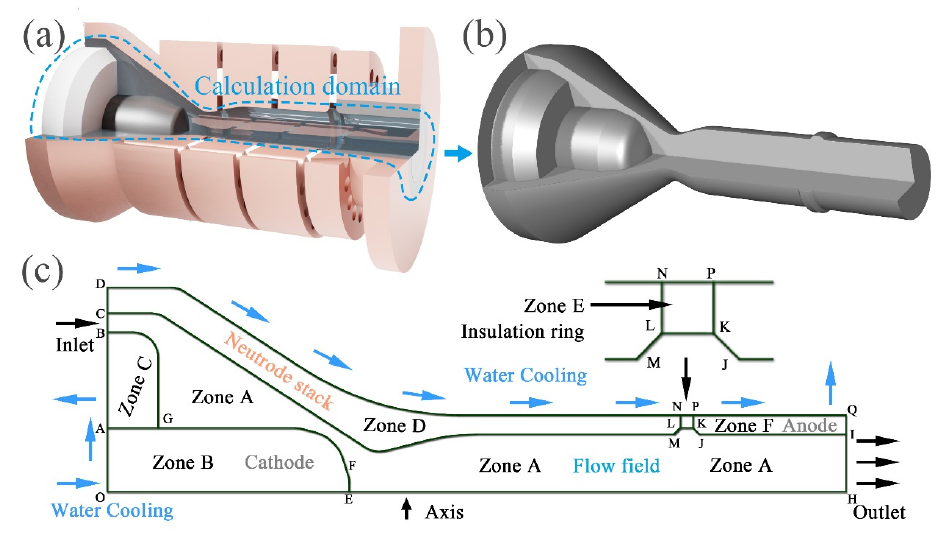
Figure 1. ( a ) Internal structure of SinplexPro™ plasma spray gun, ( b ) schematic of the 3D structure of calculation domain, and ( c ) 2D schematic of axis symmetric calculation domain. Table 2. Characteristic lengths of main boundaries of SinplexPro™ gun arcing